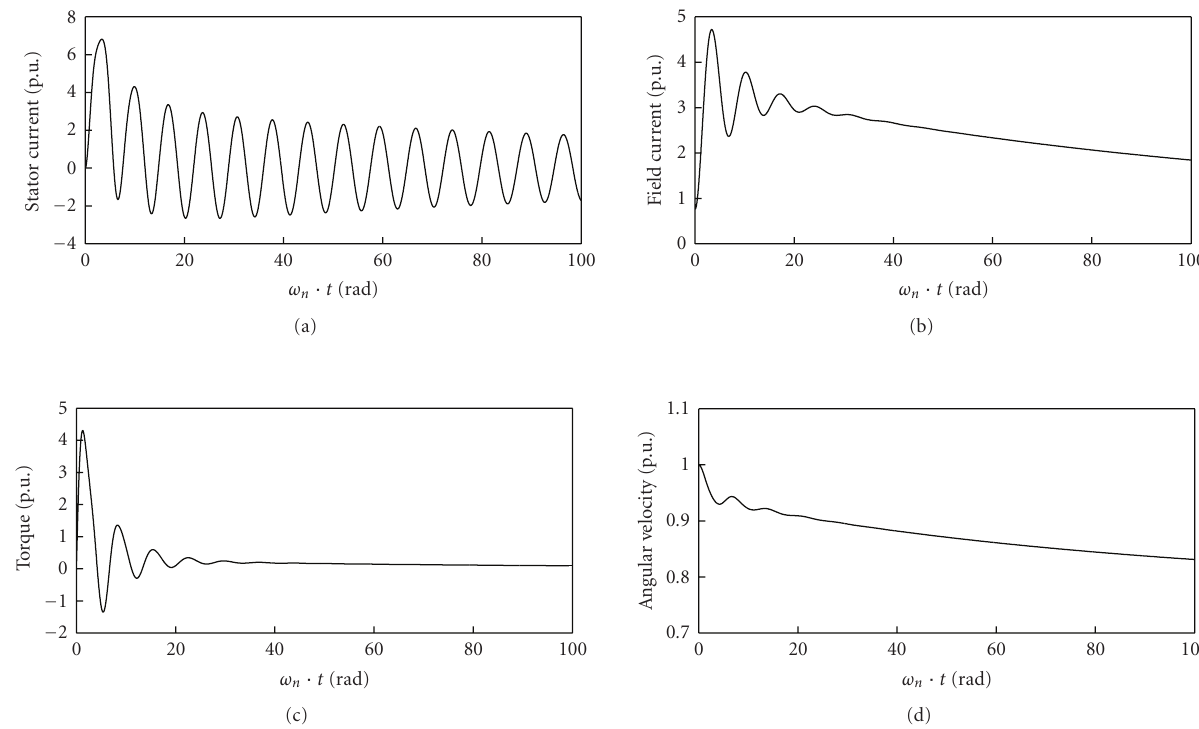
Figure 5: Time-related curves of the characteristic quantities at three-phase short circuit: (a) stator phase A current for the most unfavorable circumstance, (b) field current, (c) electromagnetic torque, (d) rotor angular velocity.